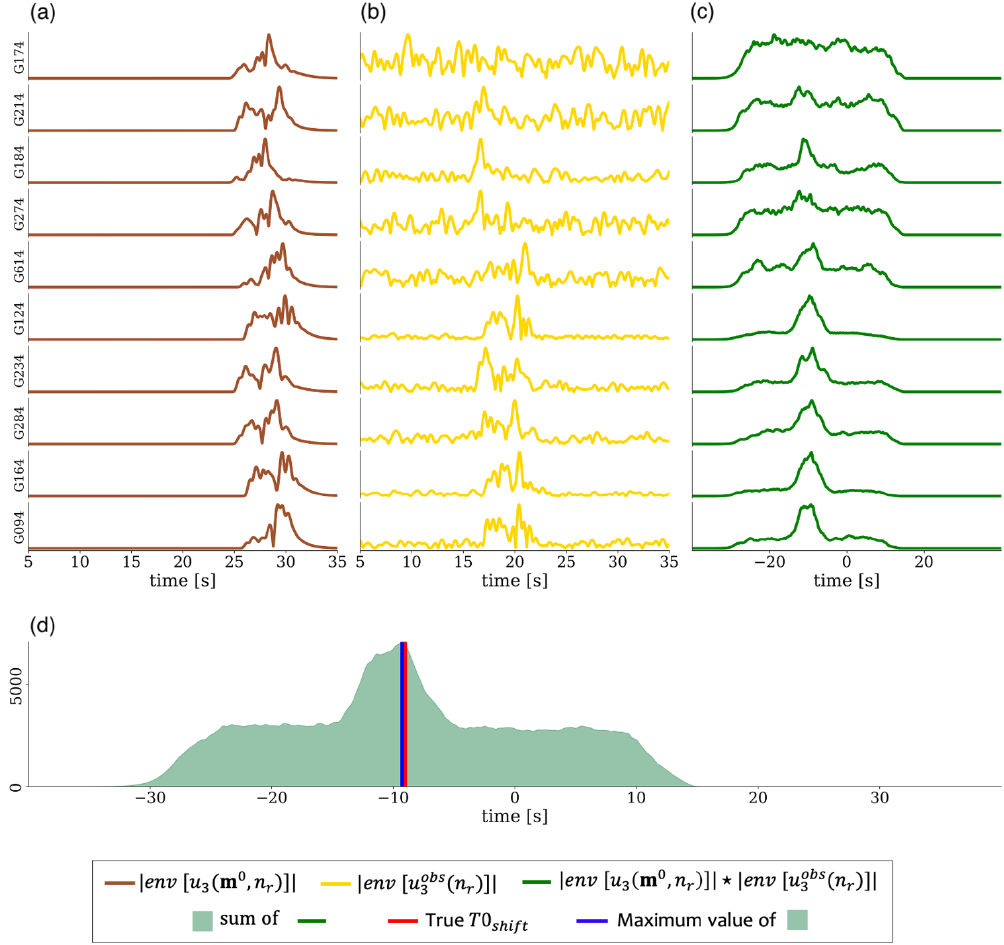
Figure 4. The results of estimating the prior mean of origin time using Eq. (18) (d) , given the envelopes of modeled displacements (a) , noisy synthetic “observed” seismograms (b) , and the convolution between (a) and (b) in (c)